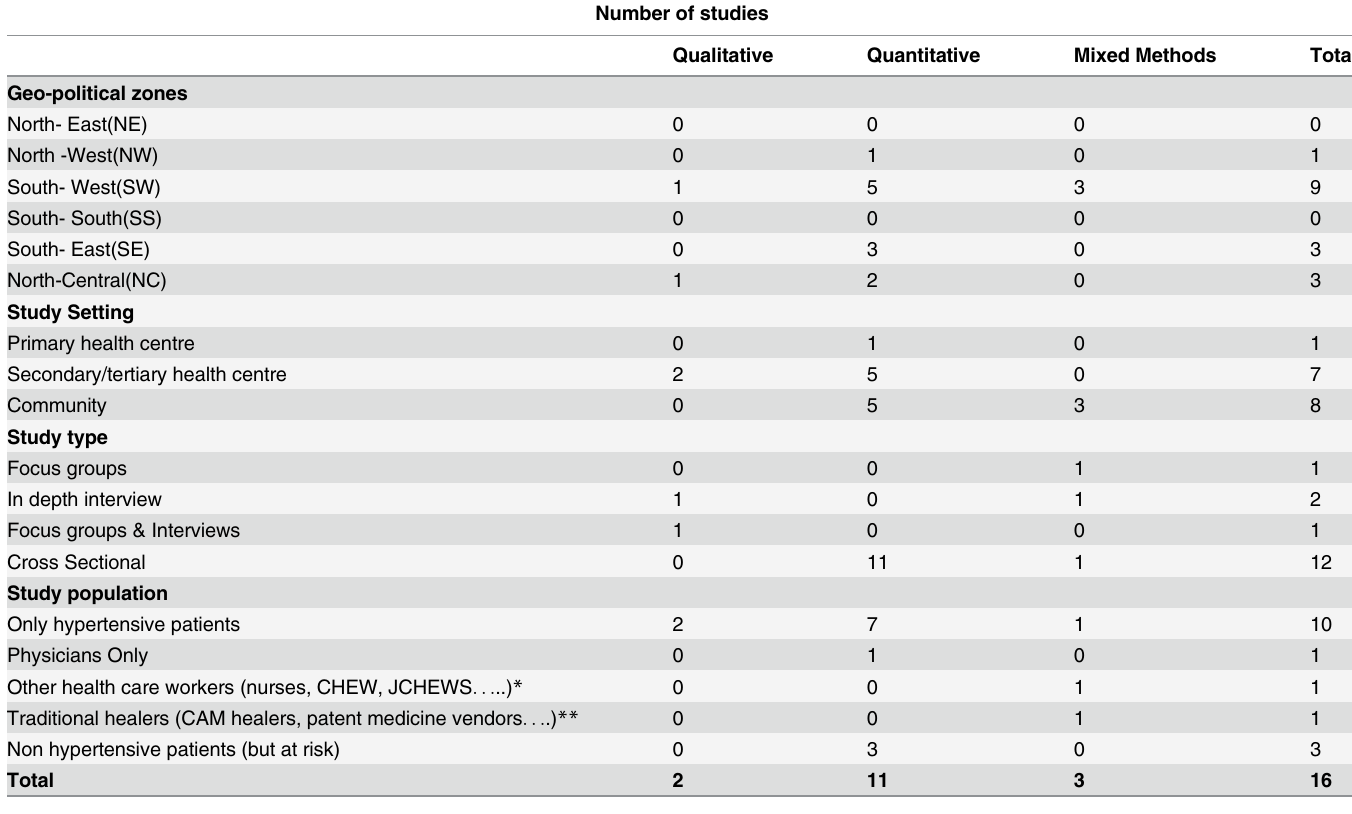
Table 2. Study characteristics (n =